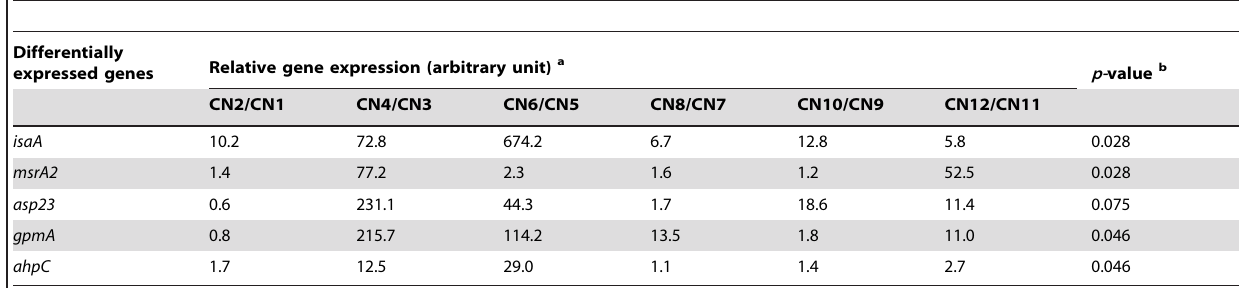
Table 4. Relative isaA , msrA2 , asp23 , gpmA and ahpC gene expression of hVISA strains compared with that of the parent strains, as determined by quantitative real-time–PCR and normalized to 16S rRNA expression.